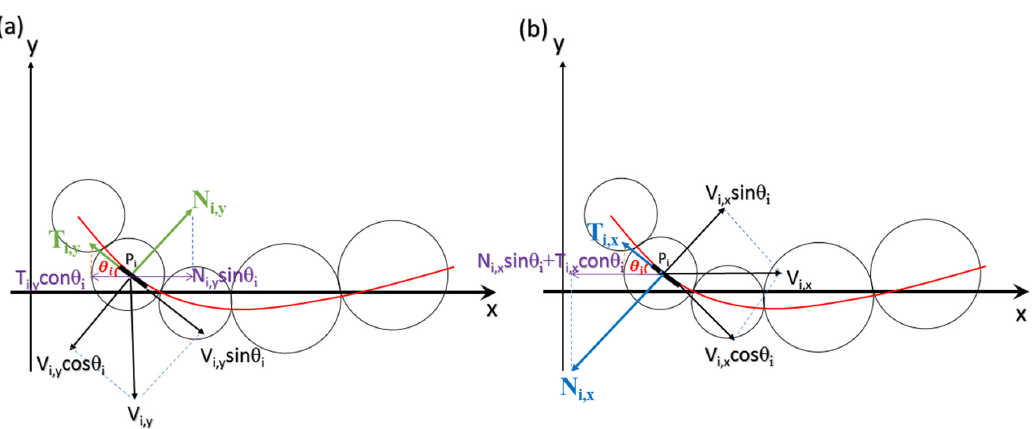
Figure 7. Schematic diagram of the forces imposed on the i th particle ( a ) when moving vertically along the axis of propulsion (x-axis) at the velocity of V i,y , or ( b ) when moving along the x-axis at the velocity of V i , x .